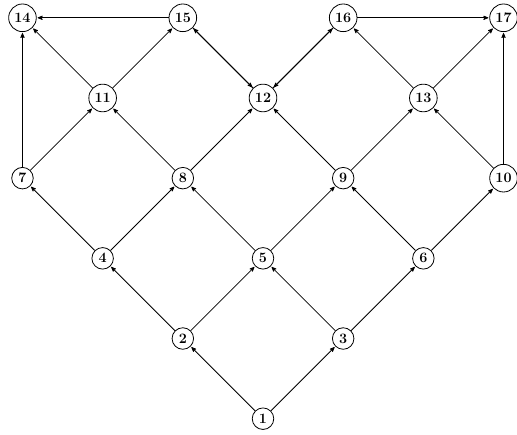
> 0 loops are not ii